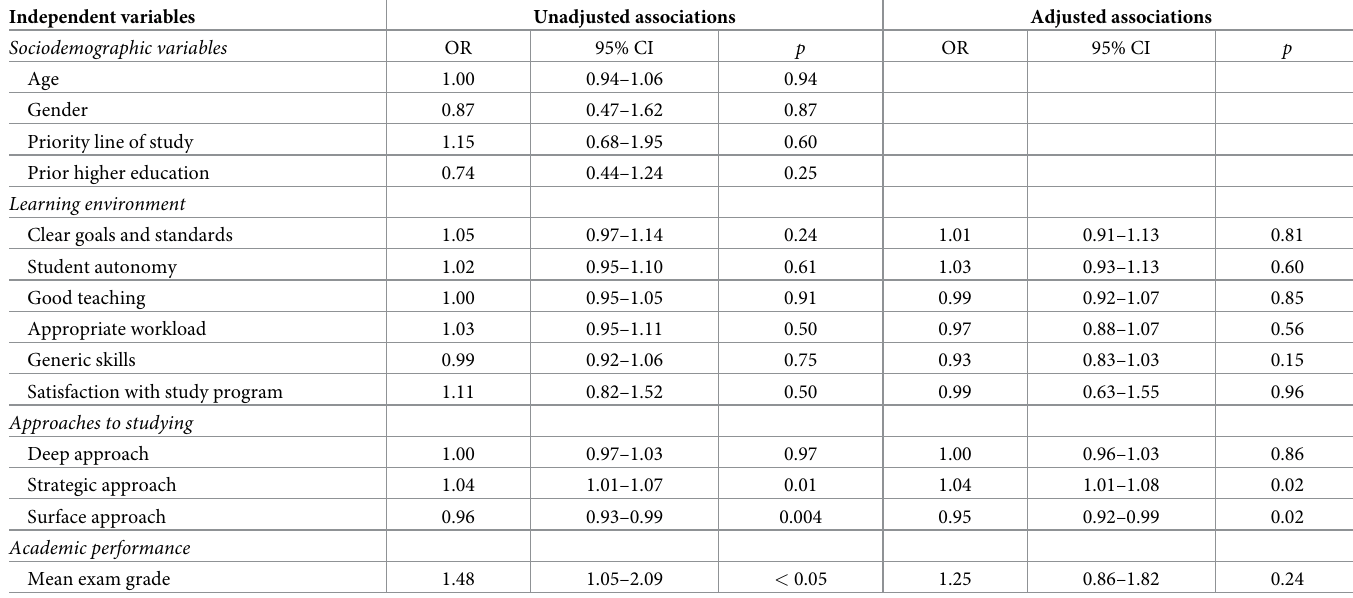
Table 2. Single and multiple binary logistic regression analyses showing associations with consistent participation in the research